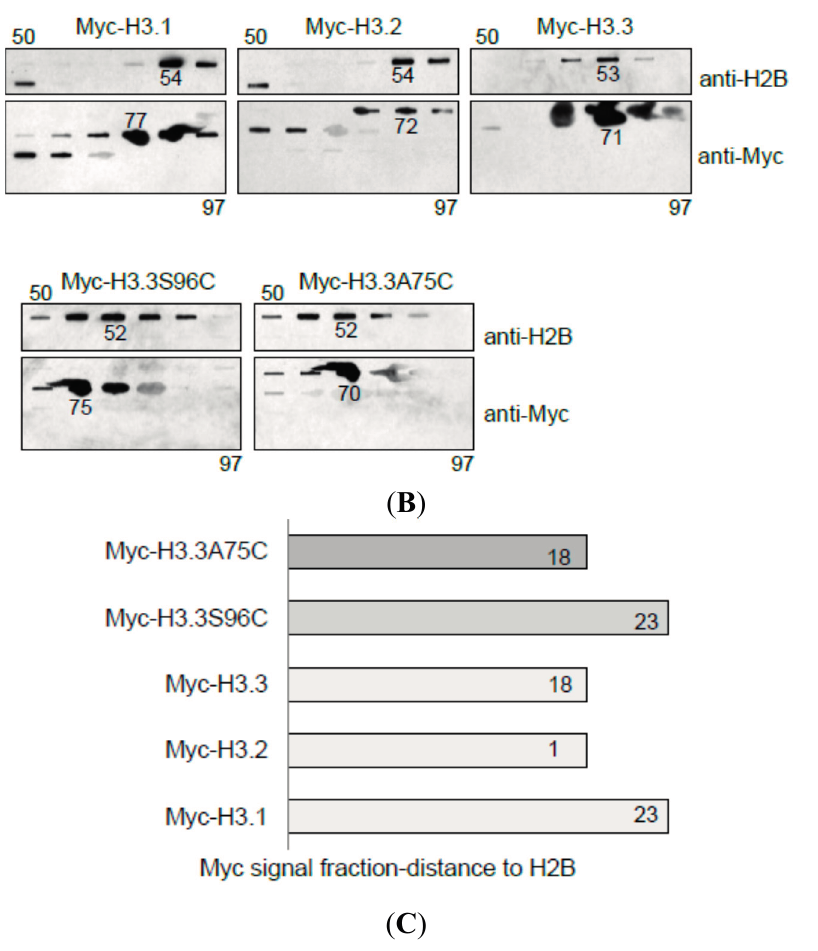
Figure 4. Analysis of myc-tagged H3 variant reverse-phase HPLC fractions. ( A ) Typical RP-HPLC profile of HeLa histones. Peaks that correspond to individual histones are labelled; ( B ) Slot immunoblots of RP-HPLC separated histone fractions 50–96 (from top left to bottom right) derived from HeLa cells transfected with indicated myc-tagged H3 wild type histones and mutants. Blots were stained with H2B ( top ) or myc ( bottom ) antibodies. H2B detection was chosen as reference elution point; ( C ) Graphical depiction of fraction numbers between strongest H2B and myc signal seen in ( B